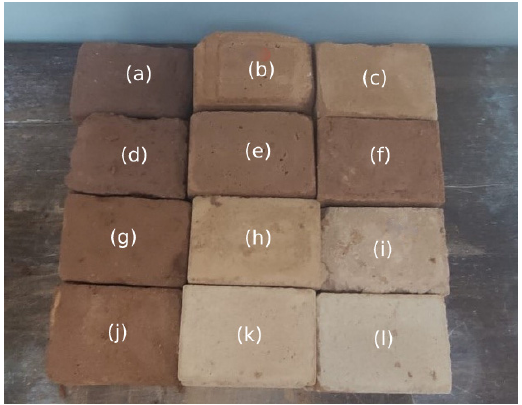
Figure 3. Samples of red earth blocks stabilized with cement and glass powder: ( a ) control sample